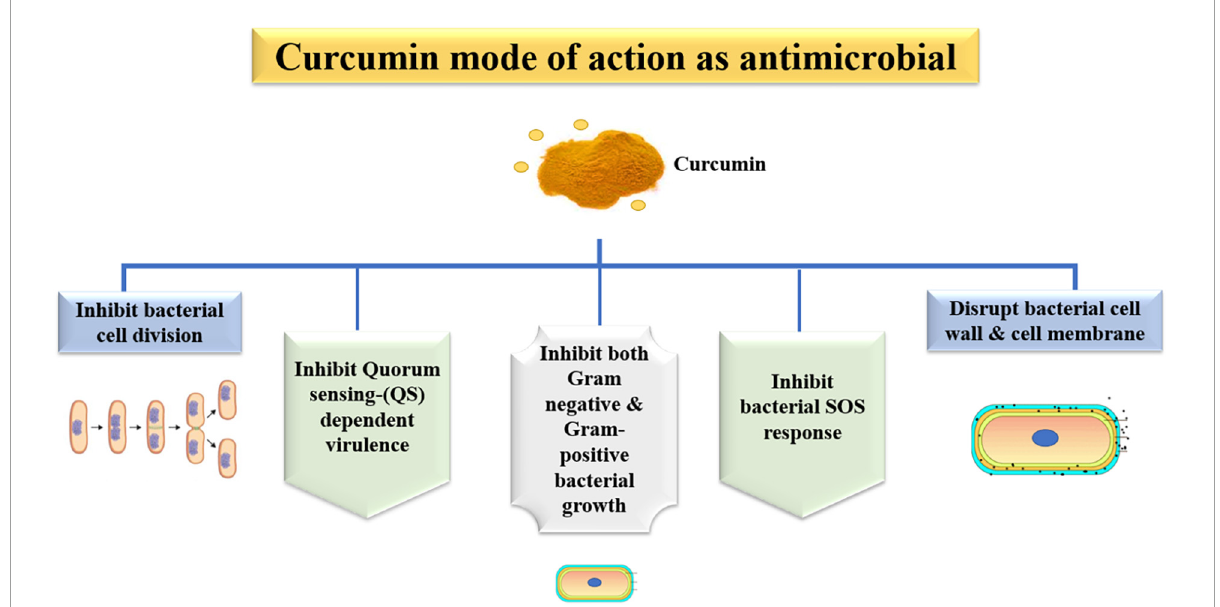
FIGURE5 Antimicrobial mechanism of bioavailable curcumin against pathogenic microorganisms.